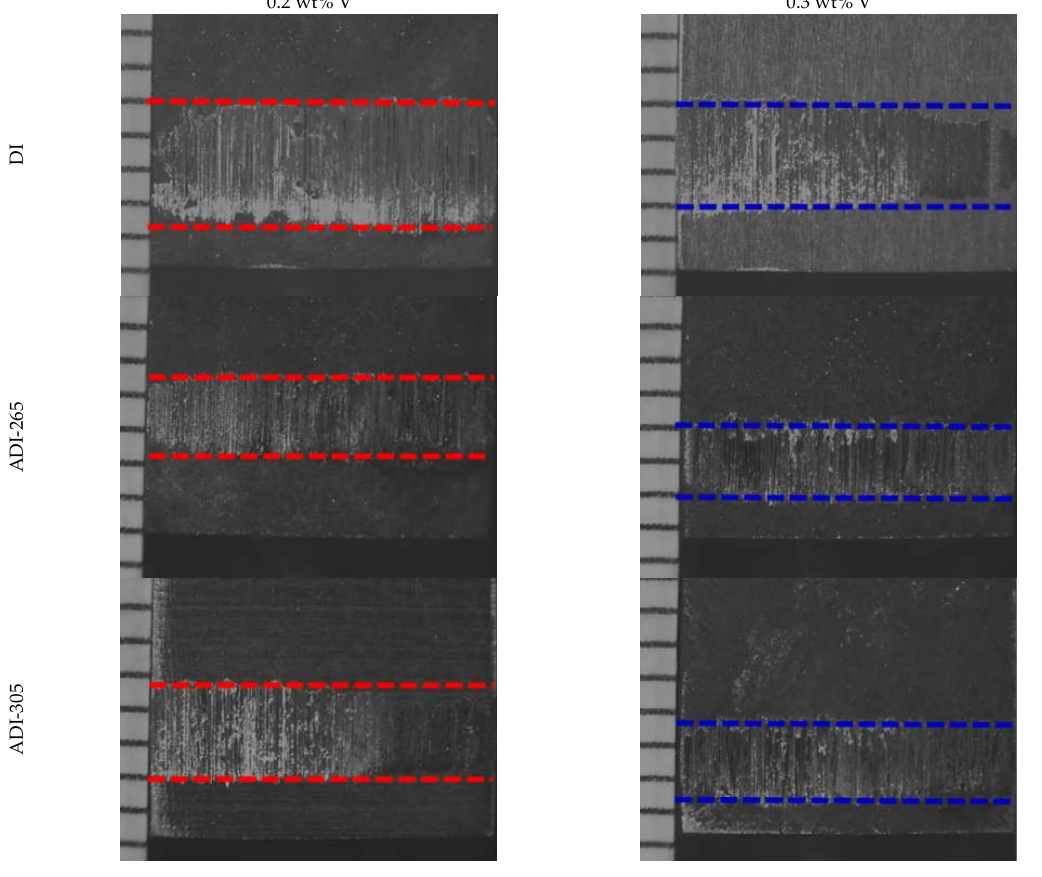
Figure 8. Wear scars samples for DI and ADI alloyed with 0.2 and 0.3 wt% V, austempered at 265 and 305 for 90 min.